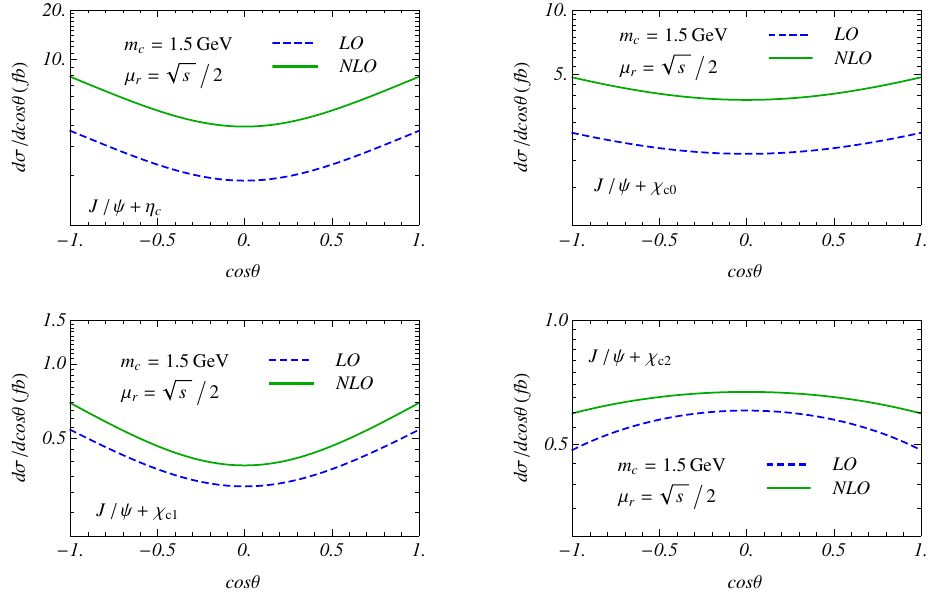
√ s = 10 . 6 GeV. m c = 1 . 5 GeV